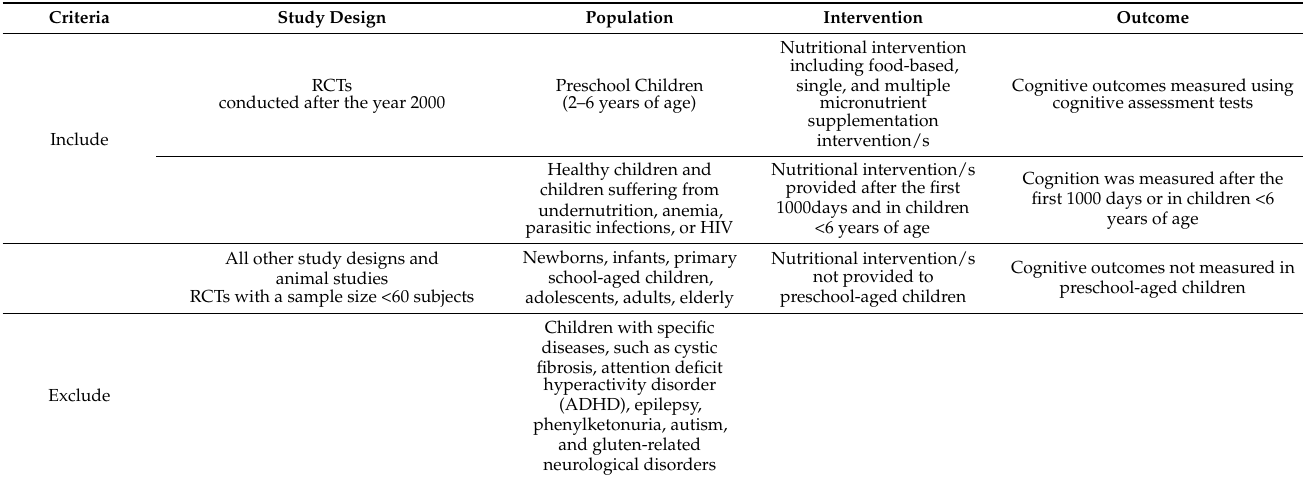
Table 1. Inclusion and Exclusion